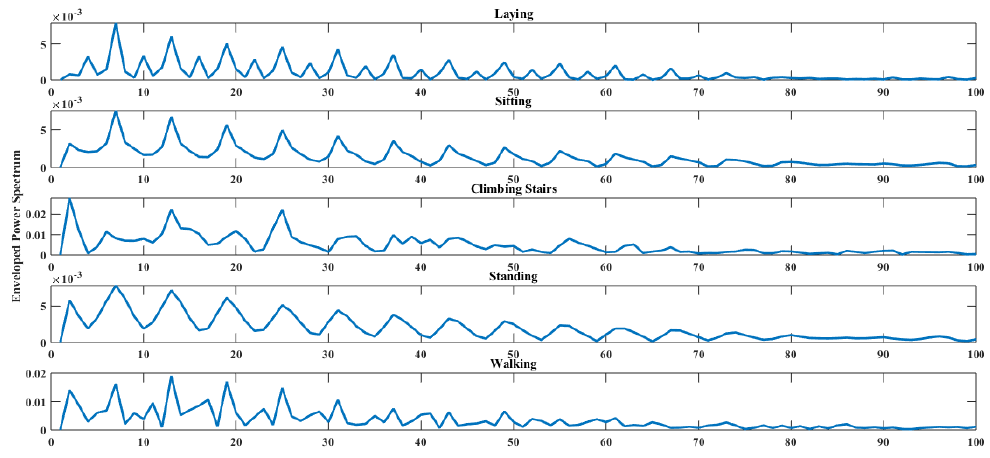
Figure 3. Enveloped power spectrum of sample signals of five